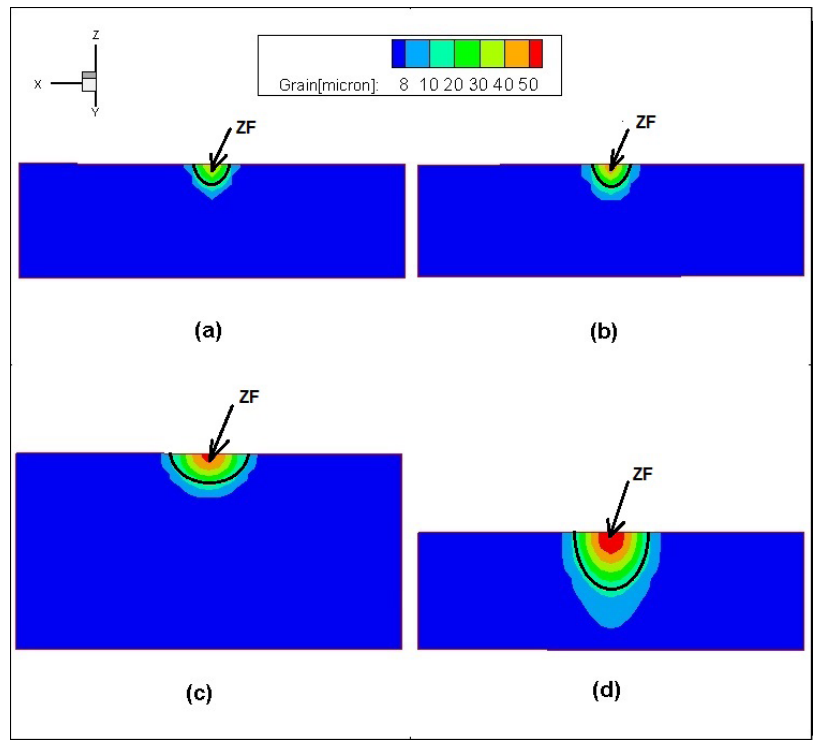
Figure 13 - Final grain size at the HAZ: (a) 0.5 kJ mm -1 (10 mm); (b) 0.5 kJ mm -1 (10 mm with preheating); (c) 3 kJ mm -1 (25 mm) and (d) 3 kJ mm -1 (10 mm)